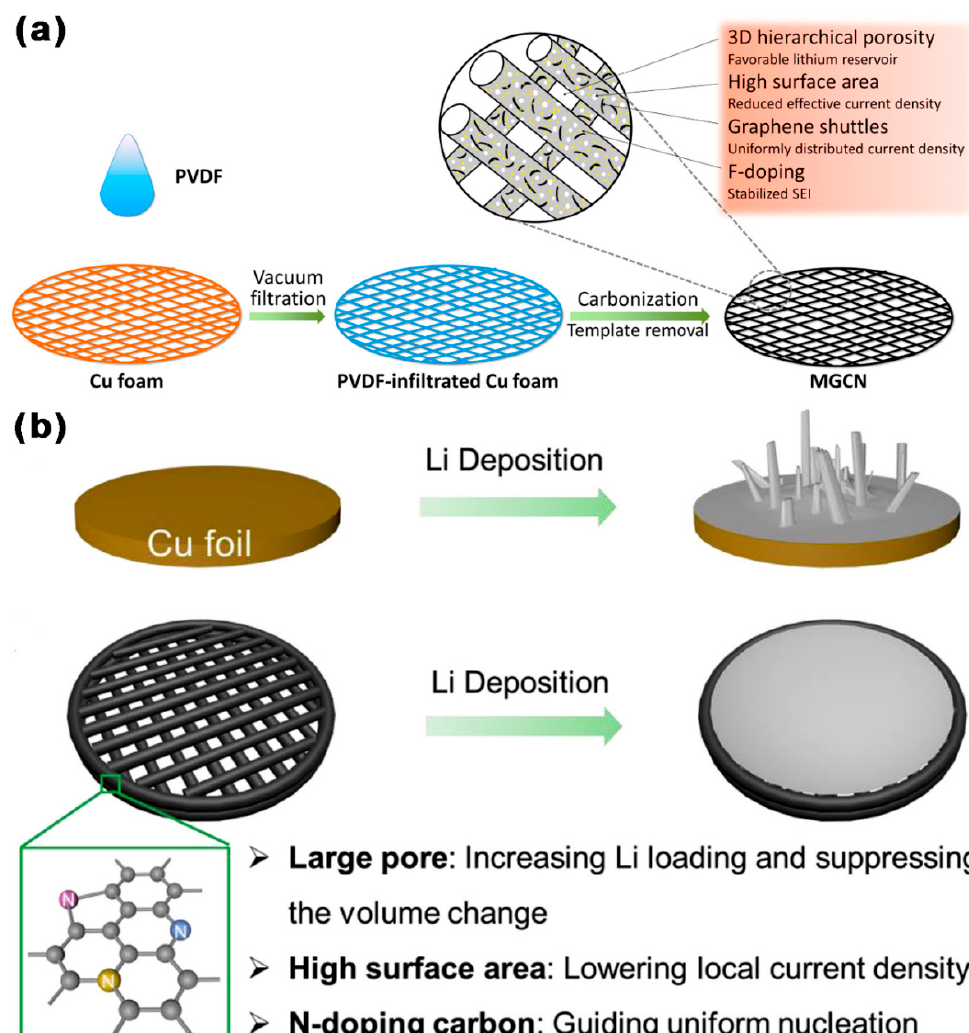
Figure 9. Schematic diagram of Li plating on ( a ) MGCN [87], and ( b ) a 3DP-NC electrode (yellow, purple, blue: N atoms) [33].